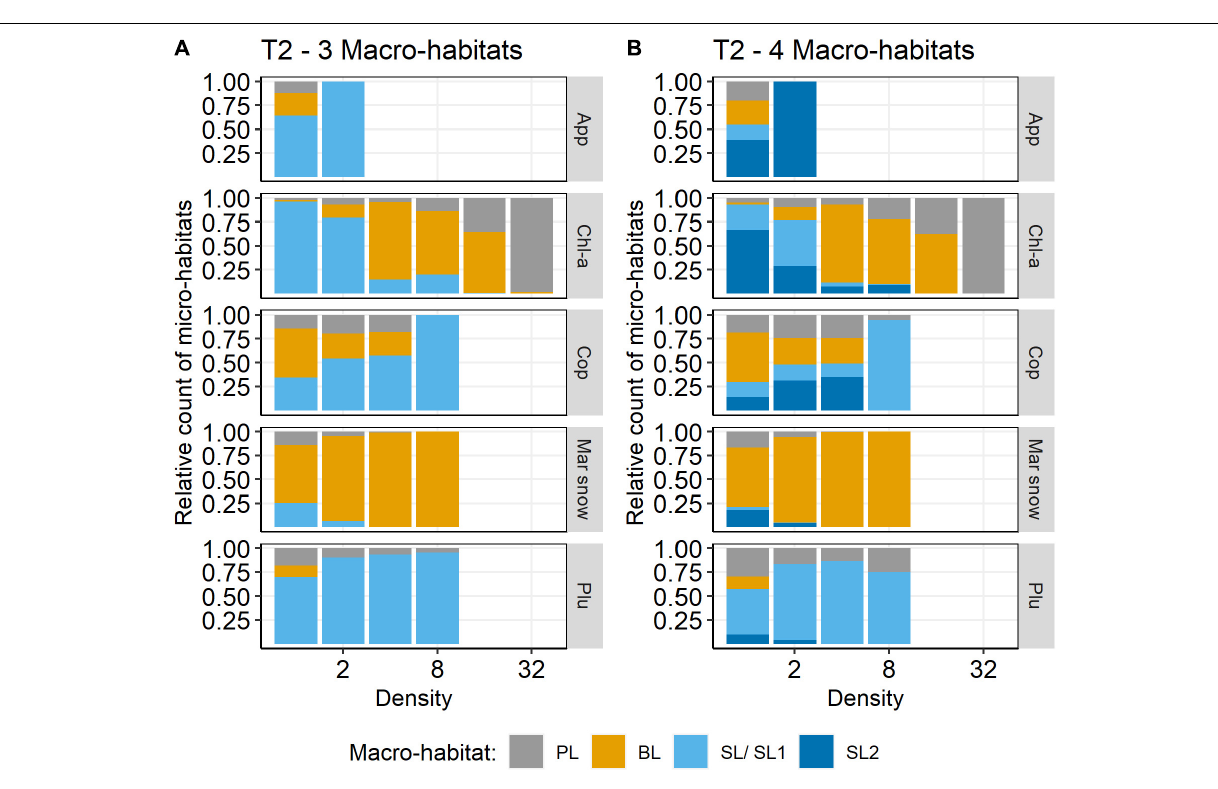
Frontiers in Marine Science |